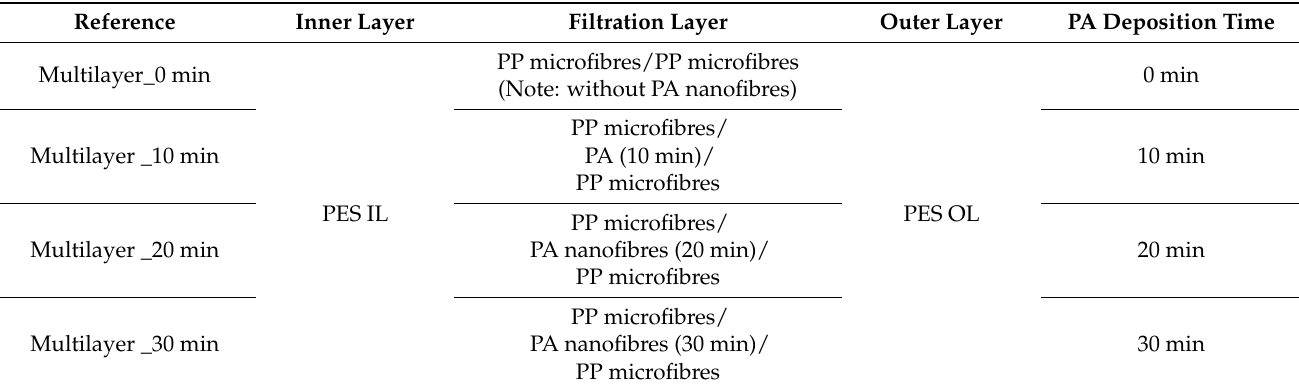
Figure 2. Multilayer system produced. Table 3. Multilayer systems tested in terms of filtration